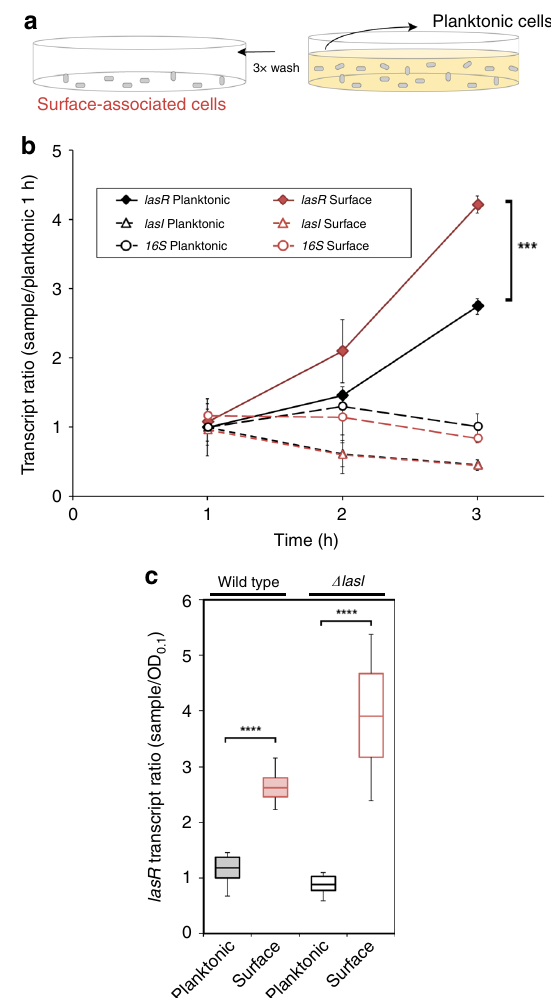
Fig. 1 Surface association increases the expression of the QS master regulator lasR . a Diagram of the experimental procedure for obtaining surface-attached and planktonic cells. b Expression of lasR and lasI and control 16S from RNA-seq time course experiments normalized by the planktonic expression at 1 h ( n = 3). The biological replicates were averaged, with the standard deviation marked with error bars. In this and all subsequent plots planktonic conditions are shown in black and surface- attached conditions are shown in red. c lasR response in a Δ lasI mutant that cannot produce 3OC12-HSL from qRT-PCR at timepoint of 1.5 h ( n = 9). This and all subsequent qRT-PCR experiments are normalized by both 5S rRNA and OD. Error bars in plots represent standard deviation, and boxes indicate the interquartile range with the center representing the mean. A two tailed student ’ s t -test was performed for comparison between samples, and signi fi cance is denoted by the asterisks (* p < 0.01, ** p < 0.01, *** p < 0.001, **** p < 0.0001). Source data are provided as a Source Data fi